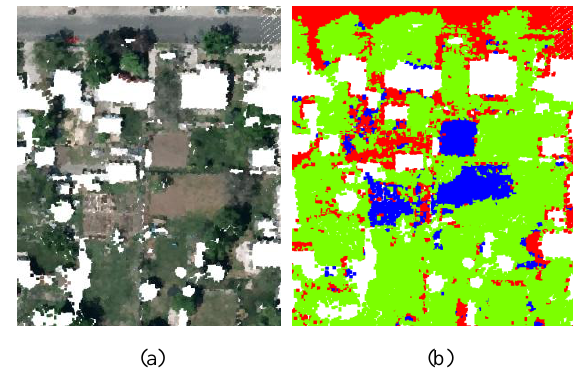
Figure 6. The classification result of ground points, (a) is the ground points colored by RGB information, (b) is the classification result coloured by classes. The points coloured by red, green, and blue are artificial ground, greenbelt, and bare land, respectively.